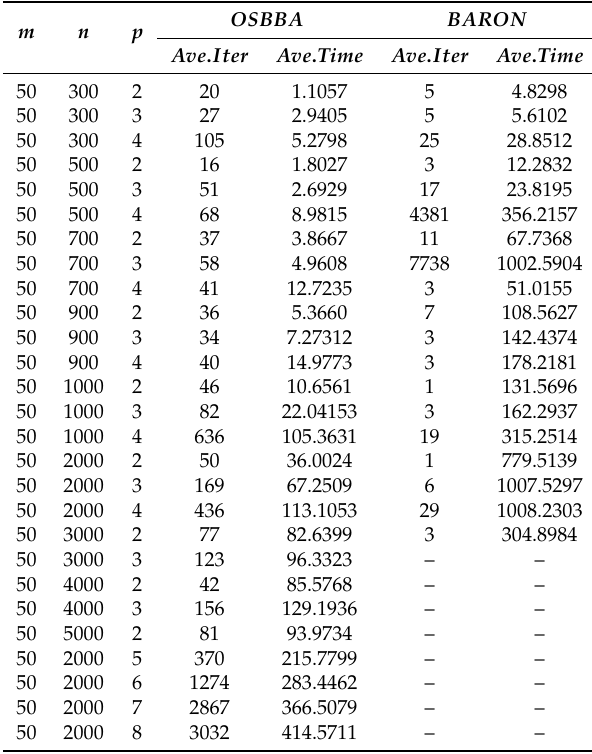
Table 7. The results of random calculations for example